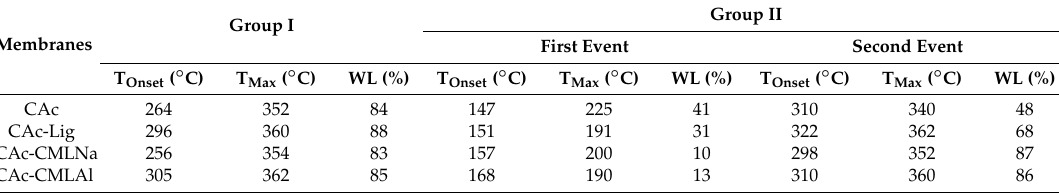
Table 2. Temperatures: onset (T Onset ), at maximum (T Max ) and rate of weight loss (WL) for the membranes, obtained from TG and DTG